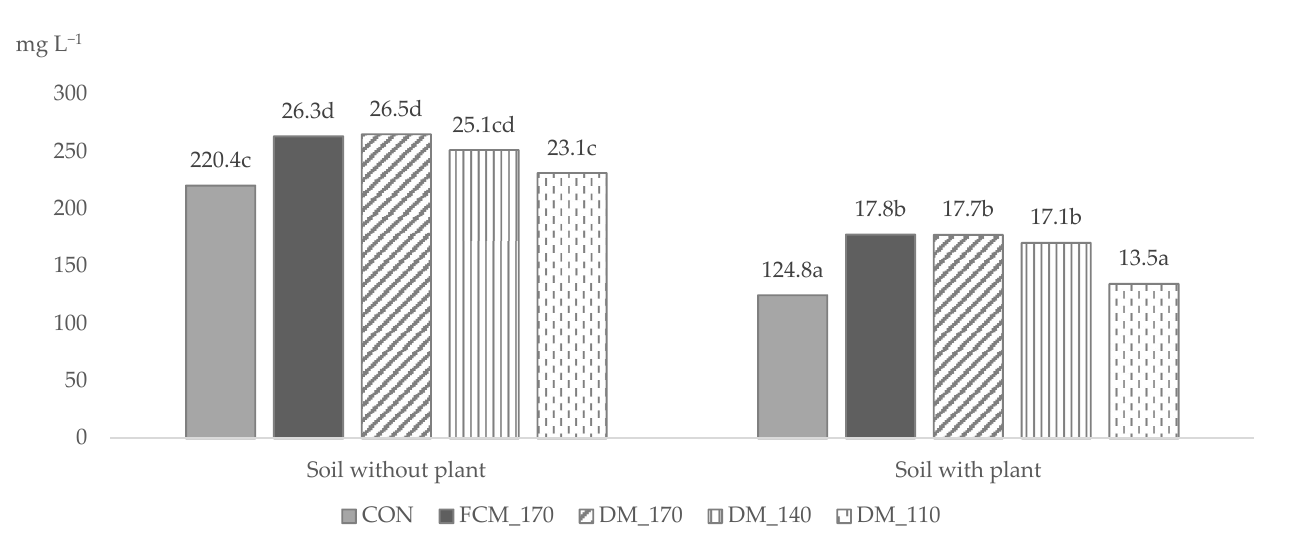
Figure 3. The effect of digestate from liquid cow manure on NH 4 -N in soil leachate. CON—control, FCM_170—Liquid cow manure N 170 , DM_170—Digestate N 170 , DM_140—Digestate N 140 , DM_110— Digestate N 110 . Values followed by different letters are significantly different ( p ≤ 0.05) based on Fisher’s LSD test.